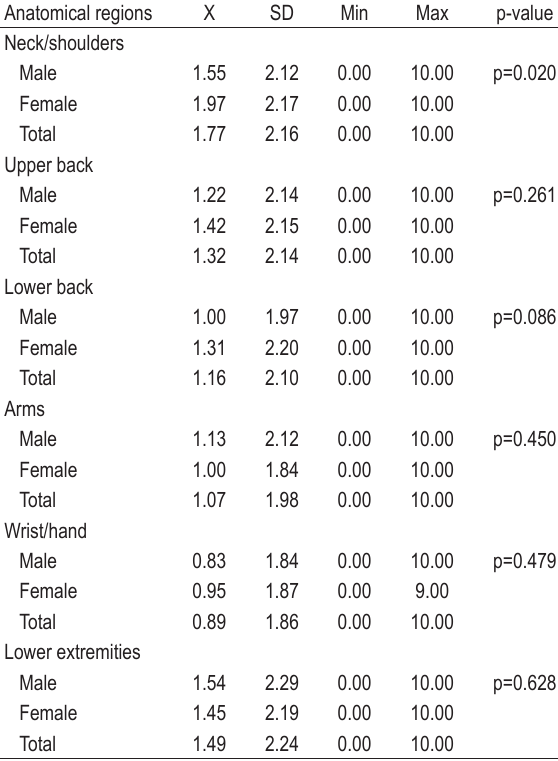
gender Anatomical